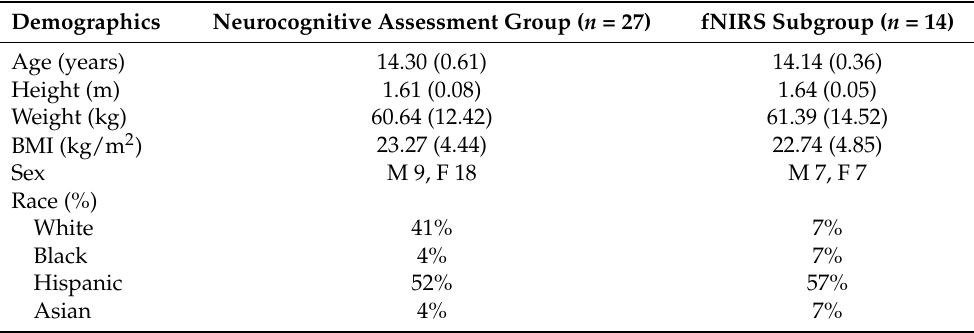
Table 1. Participant